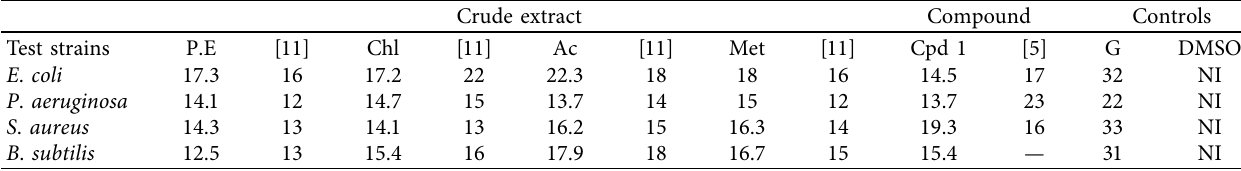
Table 2: Zone of inhibition of the extracts, compound 1 in mm. Crude extract Compound